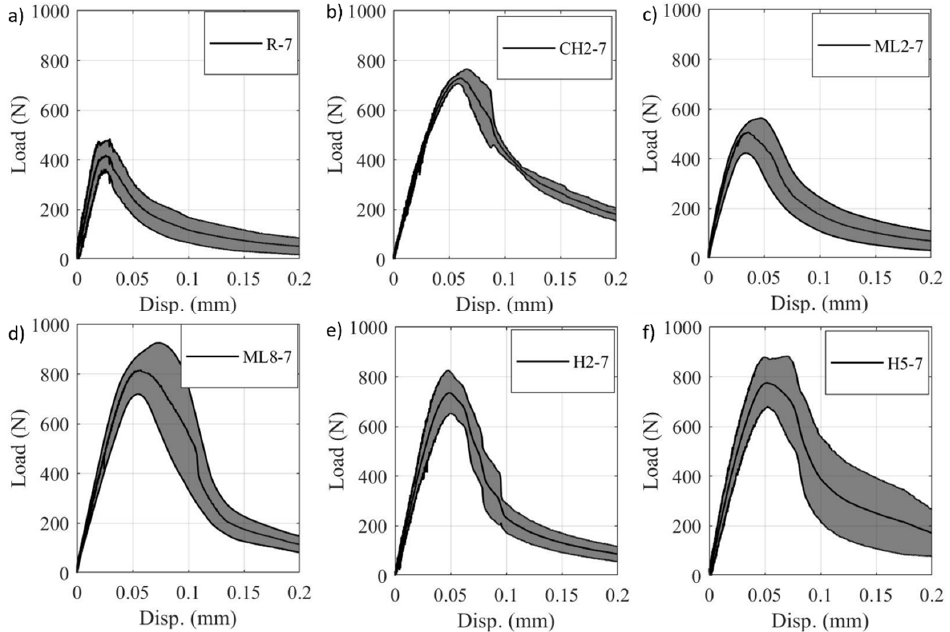
Figure 8. Comparison of unnotched beam bending mean and variance response for the ( a ) reference and carbon fiber reinforced cementitious composite mixes (( b ) CH2, ( c ) ML2, ( d ) ML8, ( e ) H2, and ( f ) H5) at seven days of age. Each graph represents the mean of five tested samples.